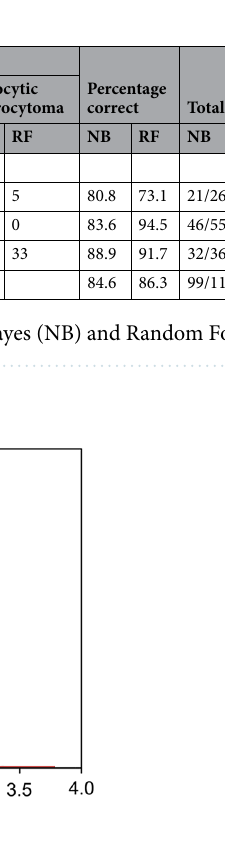
Figure 4. A plot showing the average histograms for both the Medulloblastomas, n = 55 (black) and the ATRTs, n = 4